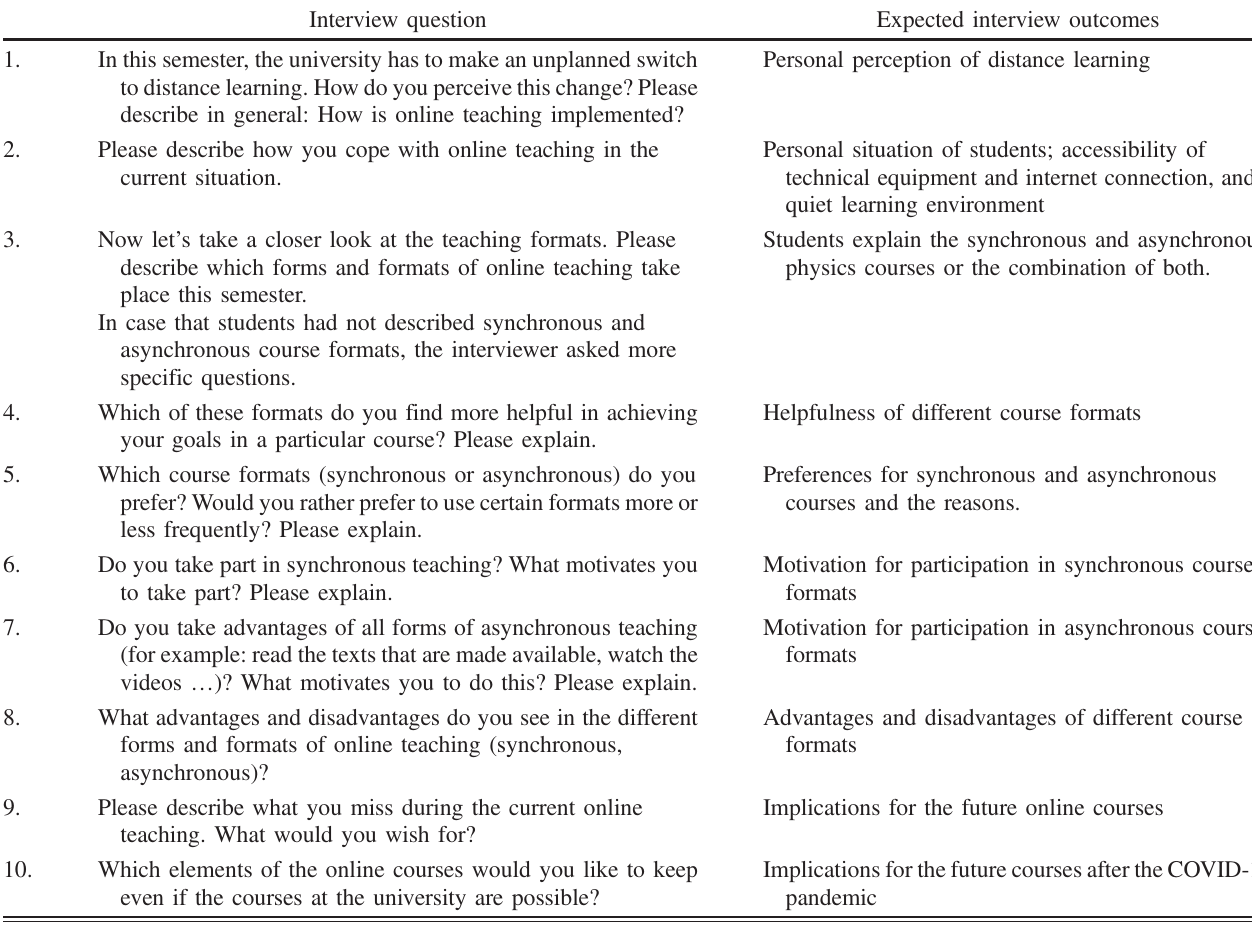
TABLE I. Interview questions related to synchronous and asynchronous physics courses and expected interview